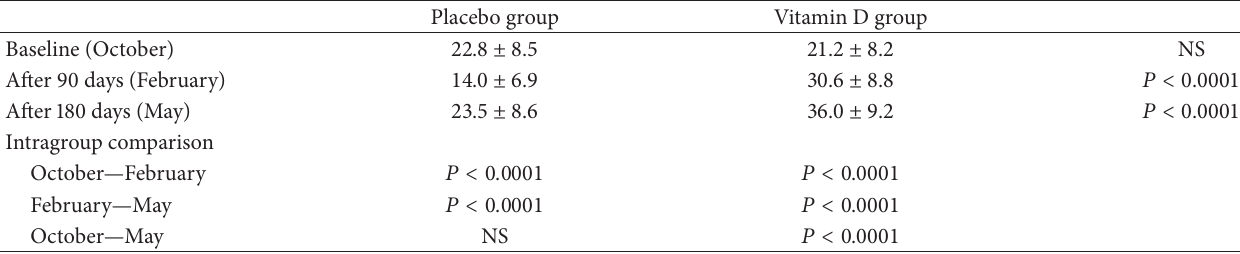
Table 2: Serum 25(OH)D (ng/mL) levels observed in a young healthy population after 3 and 6 months of supplementation with a monthly dose of 50,000 IU of cholecalciferol or a placebo. The results are expressed as mean ± SD. A P value < 0.05 is considered as significant. Placebo